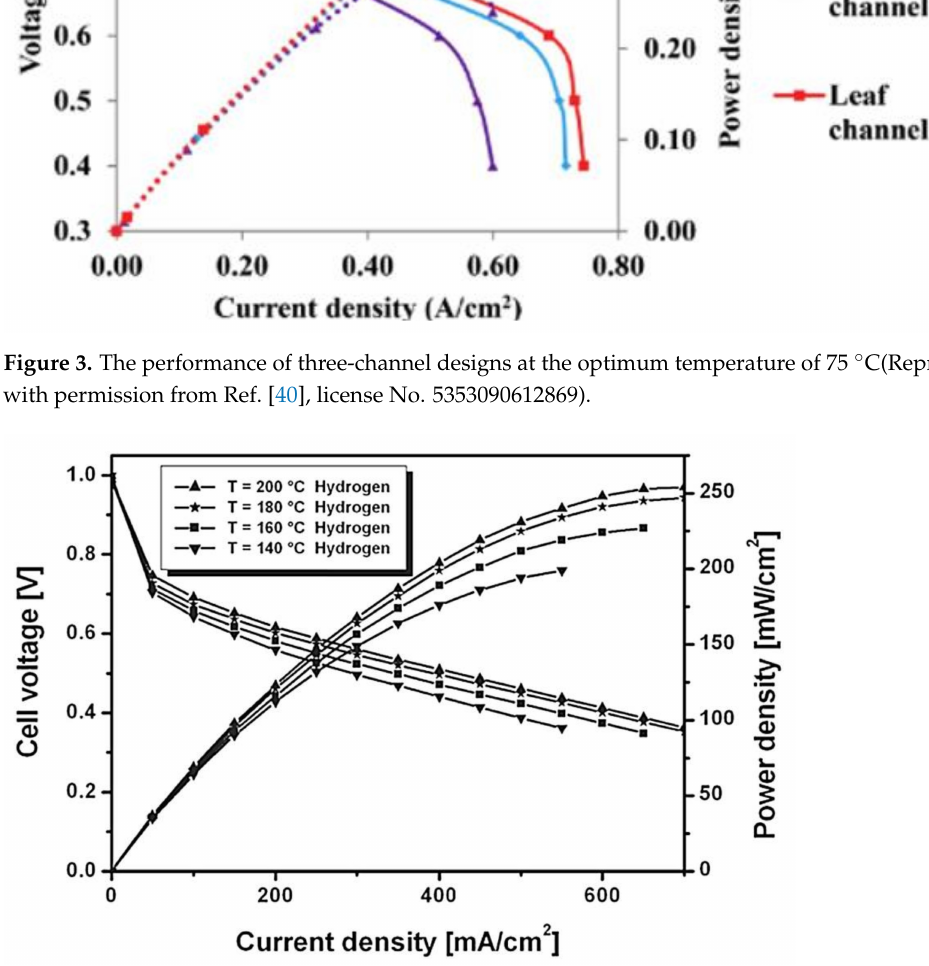
Figure 4. The effect of different operating temperatures on the performance of a H 2 -based HT-PEMFC at ambient pressure